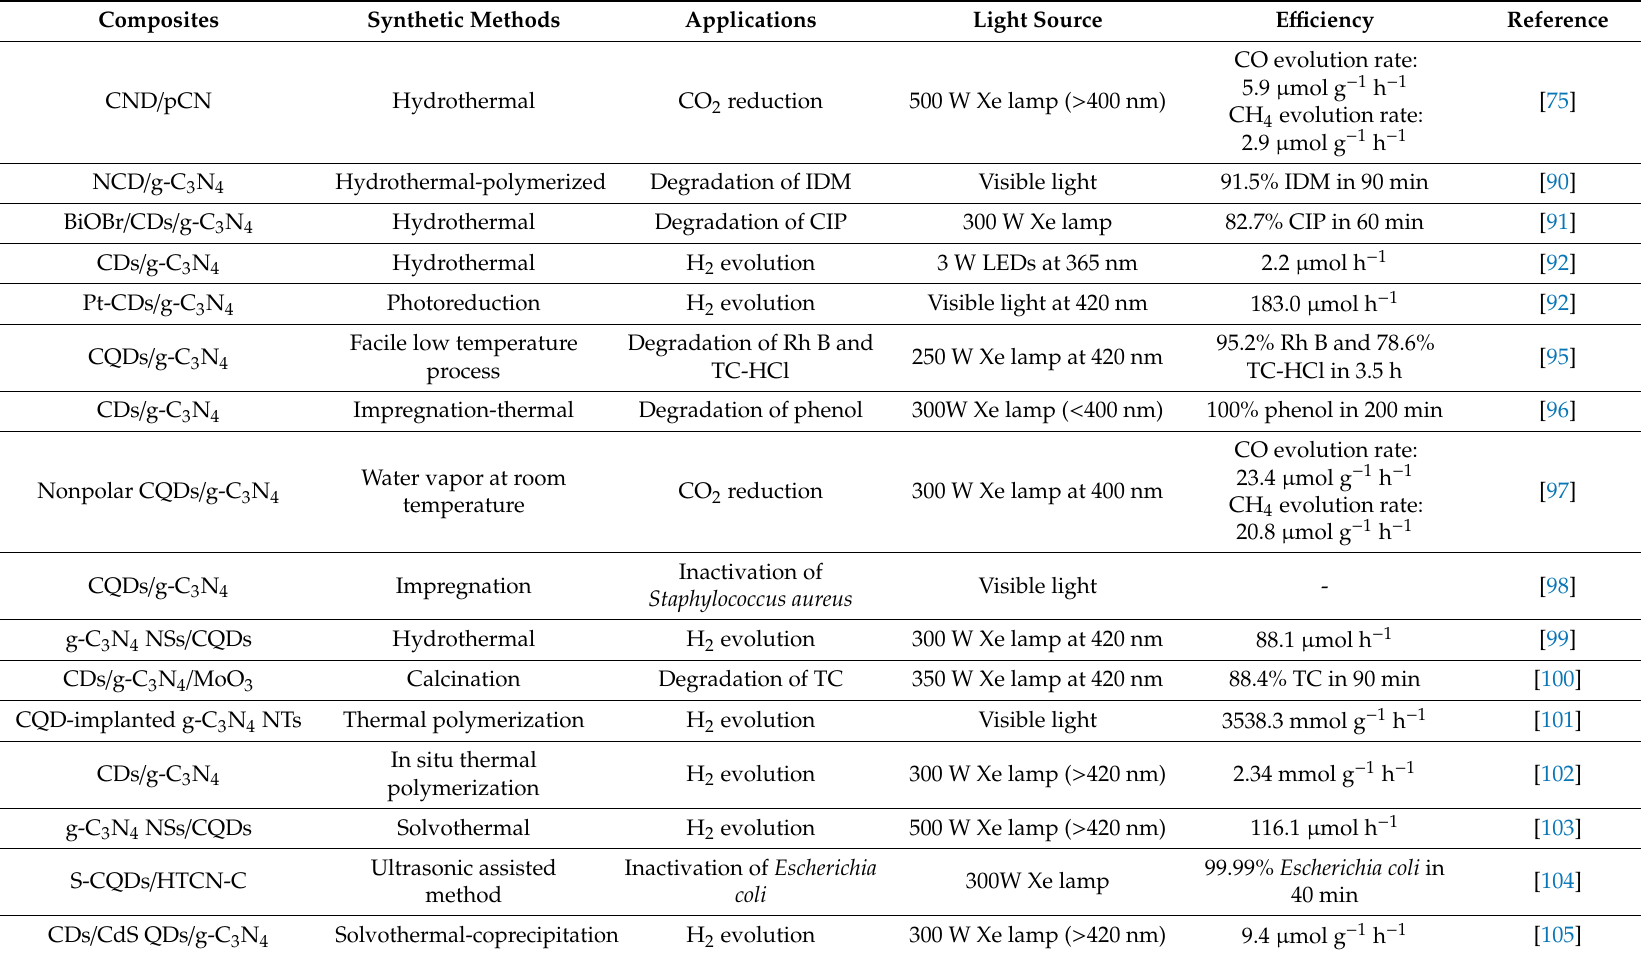
Table 1. Synthetic methods, applications, and photocatalytic e ffi ciency of QDs / g-C 3 N 4 based